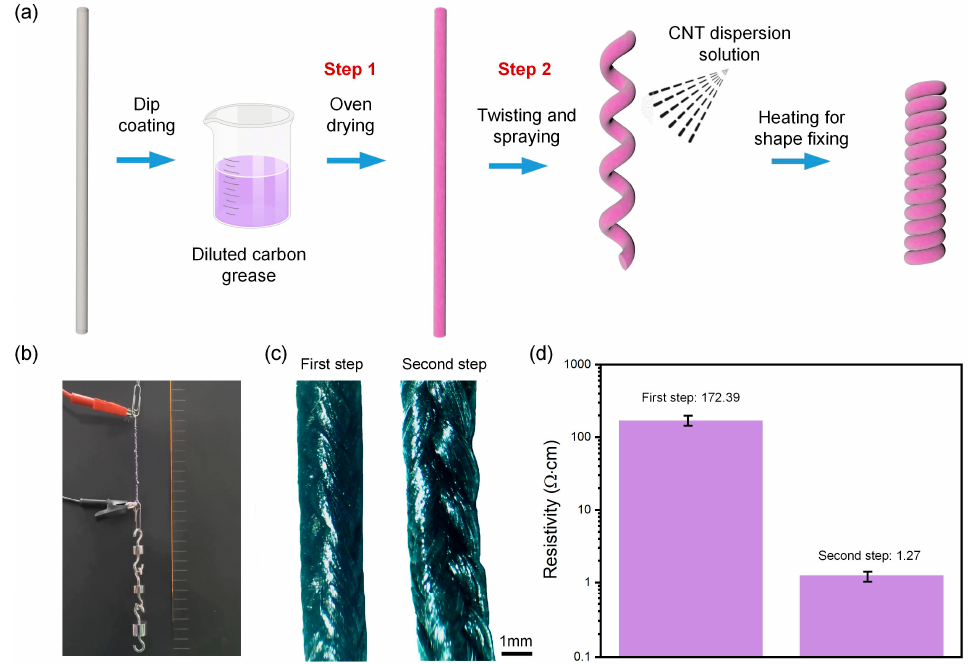
Figure 1. Fabrication and characterization of the artificial coiled yarn muscles via the two-step method. ( a ) The fabrication process of the self-aware artificial coiled yarn muscles; ( b ) The picture of the artificial coiled yarn muscles after the two-step process; ( c ) The microscopic optical images of muscle after the first step (left) and second steps (right); ( d ) The resistivity of the muscle after the first step and second steps.